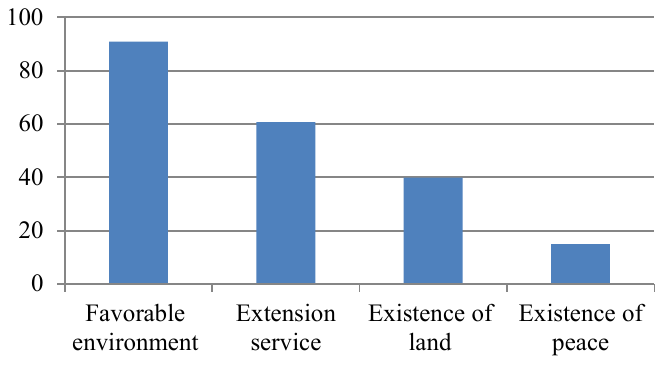
Figure 3. Opportunities of small-scale plantations in percent (n =